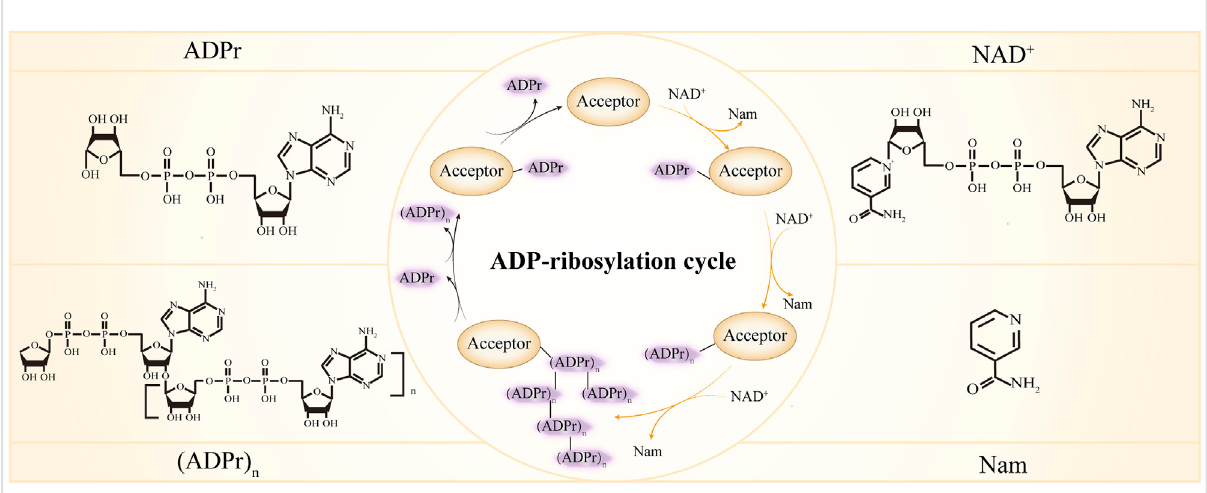
FIGURE 1 ADP-ribosylation cycle. ADPr, ADP-ribose; NAD + , Nicotinamide adenine dinucleotide; Nam, nicotinamide. In the center inner circle, the reactionsindicatedbytheyellowarrowsarecatalyzedbyADP-ribosylationwriters,thereactionsindicatedbytheblackarrowsarecatalyzedbyADP- ribosylation erasers and different forms of ADP-ribose are recognized by ADP-ribosylation readers.